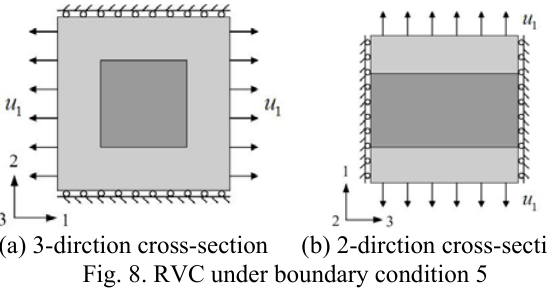
Fig. 8. RVC under boundary condition 5